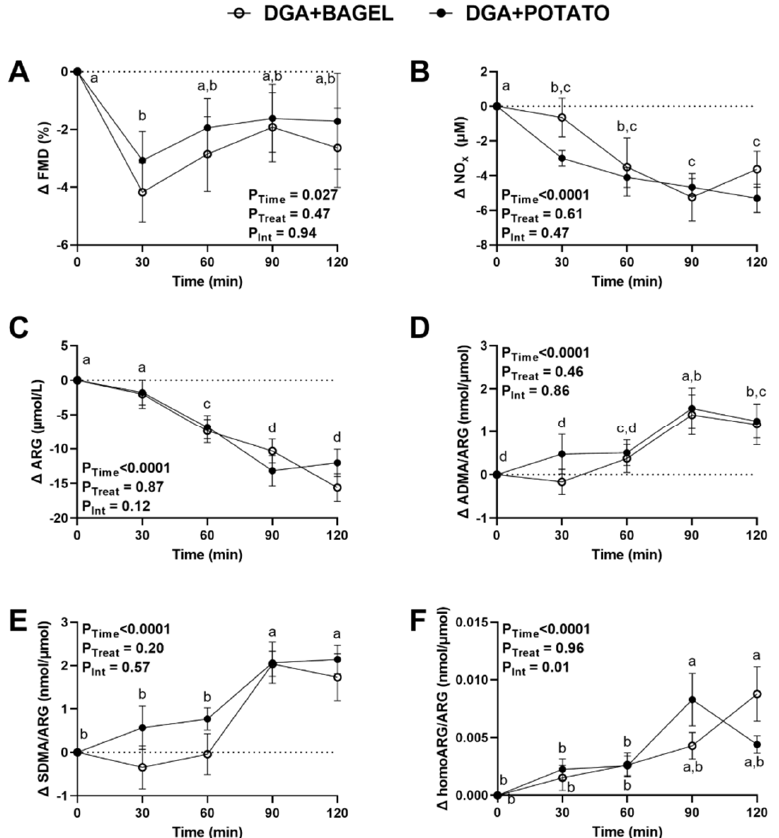
Figure 3. Vascular endothelial function and plasma biomarkers of nitric oxide homeostasis in MetS persons who followed a DGA -based diet containing potatoes (DGA + POTATO) or bagels (DGA + BAGEL) for 2 w prior to completing an oral glucose tolerance test. ( A ) Brachial artery FMD, and plasma ( B ) NOx, ( C ) ARG, ( D ) ADMA/ARG, ( E ) SDMA/ARG, and ( F ) homoARG/ARG during a 2- h postprandial period following the ingestion of 75 g of glucose. Data (means ± SE, n = 27) are